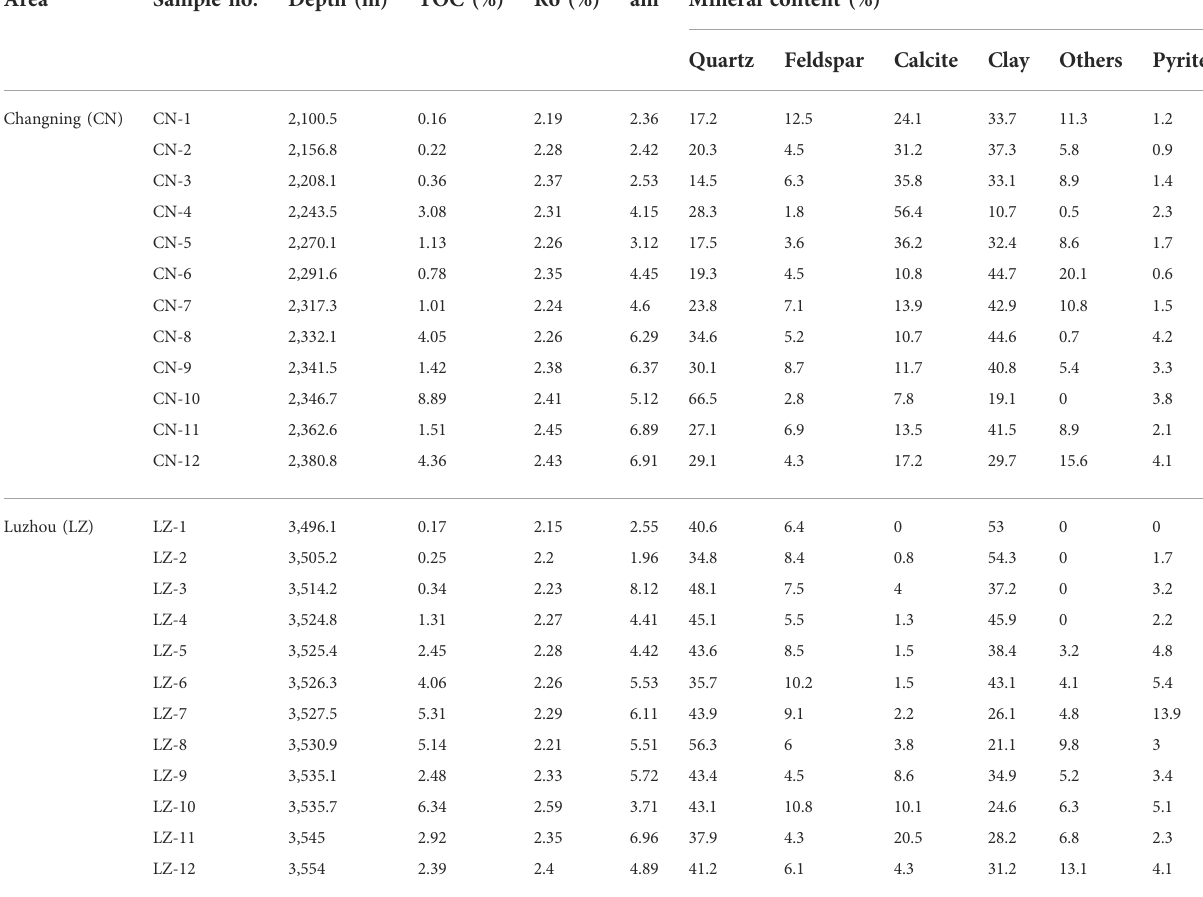
TABLE 1 Mineral components and contents in the longmaxi formation shale in the study area. Area Sample